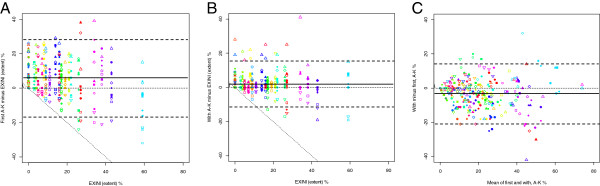
The relationship between the evaluations made by EXINI (extent) and the physicians, shown as Bland Altman plots. The left diagram shows the relationship between EXINI and the first evaluation by the physicians (A). “First A-K” on the y axis represents first delineations for the physicians (A-K). The middle diagram shows the relationship between EXINI and the evaluation by the physicians when they were provided with a suggestion by EXINI (B). “With A-K” on the y axis represents the second delineation (with suggestion by EXINI) for the physicians (A-K). The third diagram shows the relationship between the first and second (“with”) delineations made by the physicians (C). The solid line represents mean value, and the heavy dotted lines represent ±1.96 SD. For diagram A and B, the thin dotted diagonal line represents the limit of maximum possible difference (i.e. no value is possible below this line). The twenty-five colours represent the 25 different patients and the 11 symbols represent the 11 physicians (A-K).